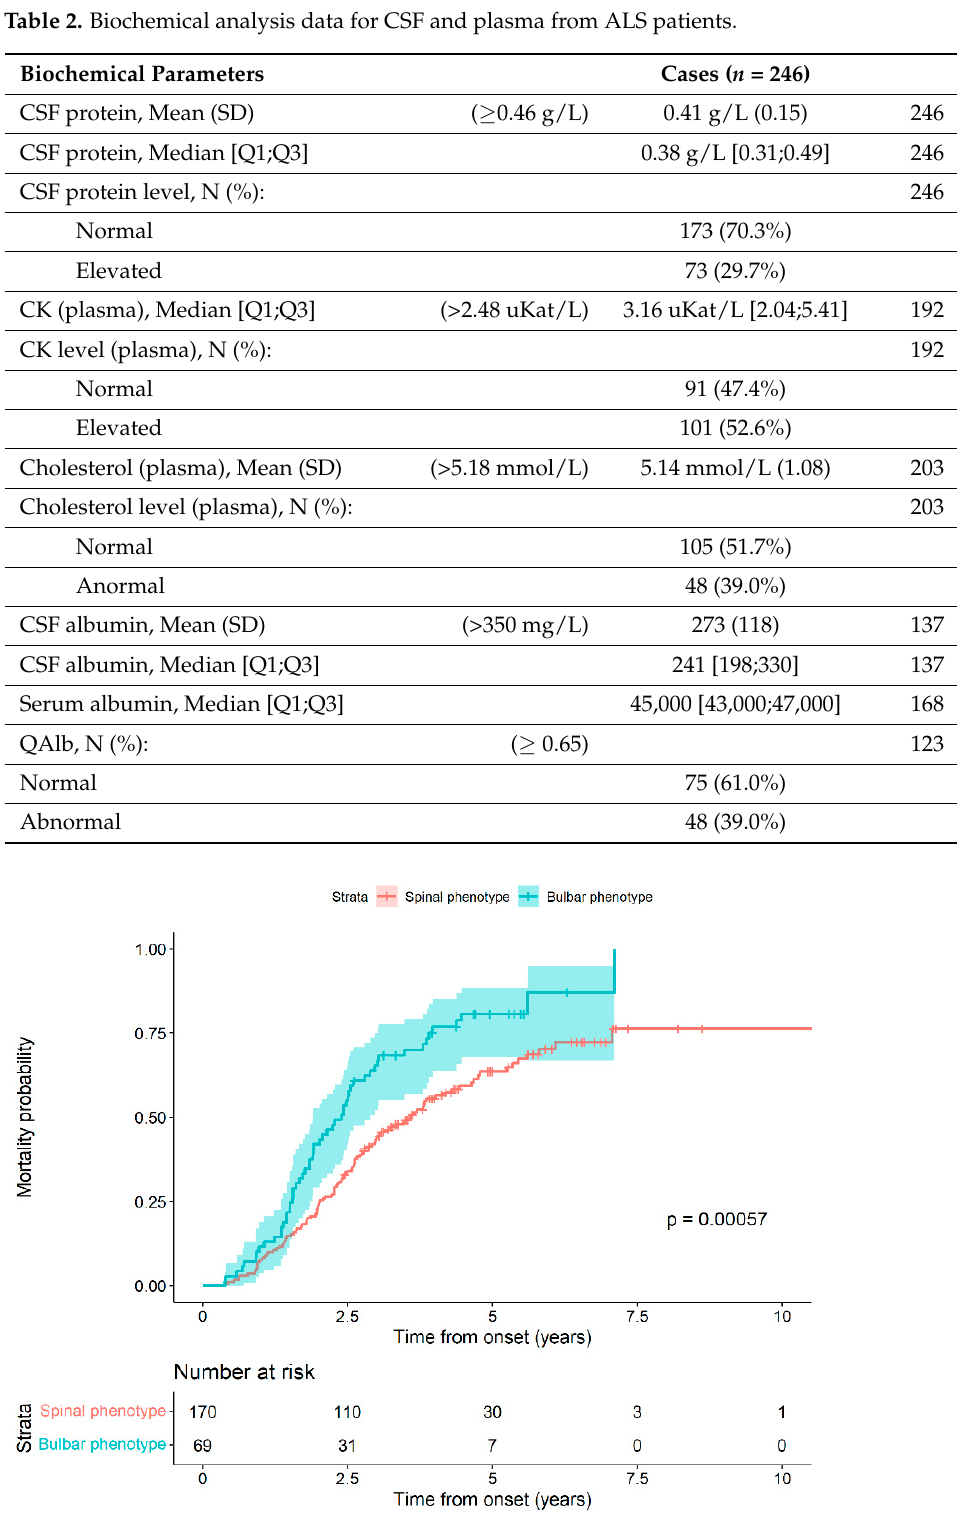
Figure 1. Mortality probability in relation to phenotype as a function of follow-up time from